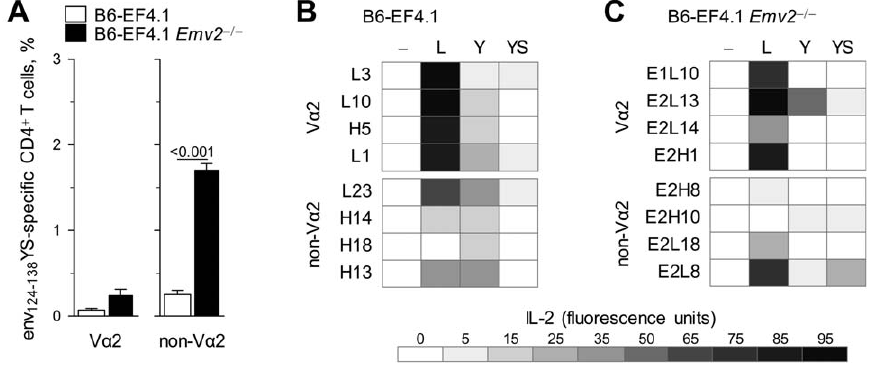
Figure 6. Cross-reactivity of individual V a 2 or non-V a 2 CD4 + T cells. (A) Frequency of env 124-138 YS-reactive cells in V a 2 or non-V a 2 CD4 + T cells isolated from either B6 (B6-EF4.1) or Emv2 -deficient B6 (B6-EF4.1 Emv2 2 / 2 ) EF4.1 mice. Data are the means 6 SEM ( n =9) of 18-hr stimulations from 3 experiments. (B–C) IL-2 production in response to stimulation with 5 6 10 2 6 M env 124-138 L (L), env 124-138 Y (Y) or env 124-138 YS (YS) in comparison with the absence of peptide stimulation (-) of V a 2 or non-V a 2 env 124-138 L-reactive hybridoma T cell lines derived from Emv2 + / + (B) or Emv2 2 / 2 (C) EF4.1 mice.